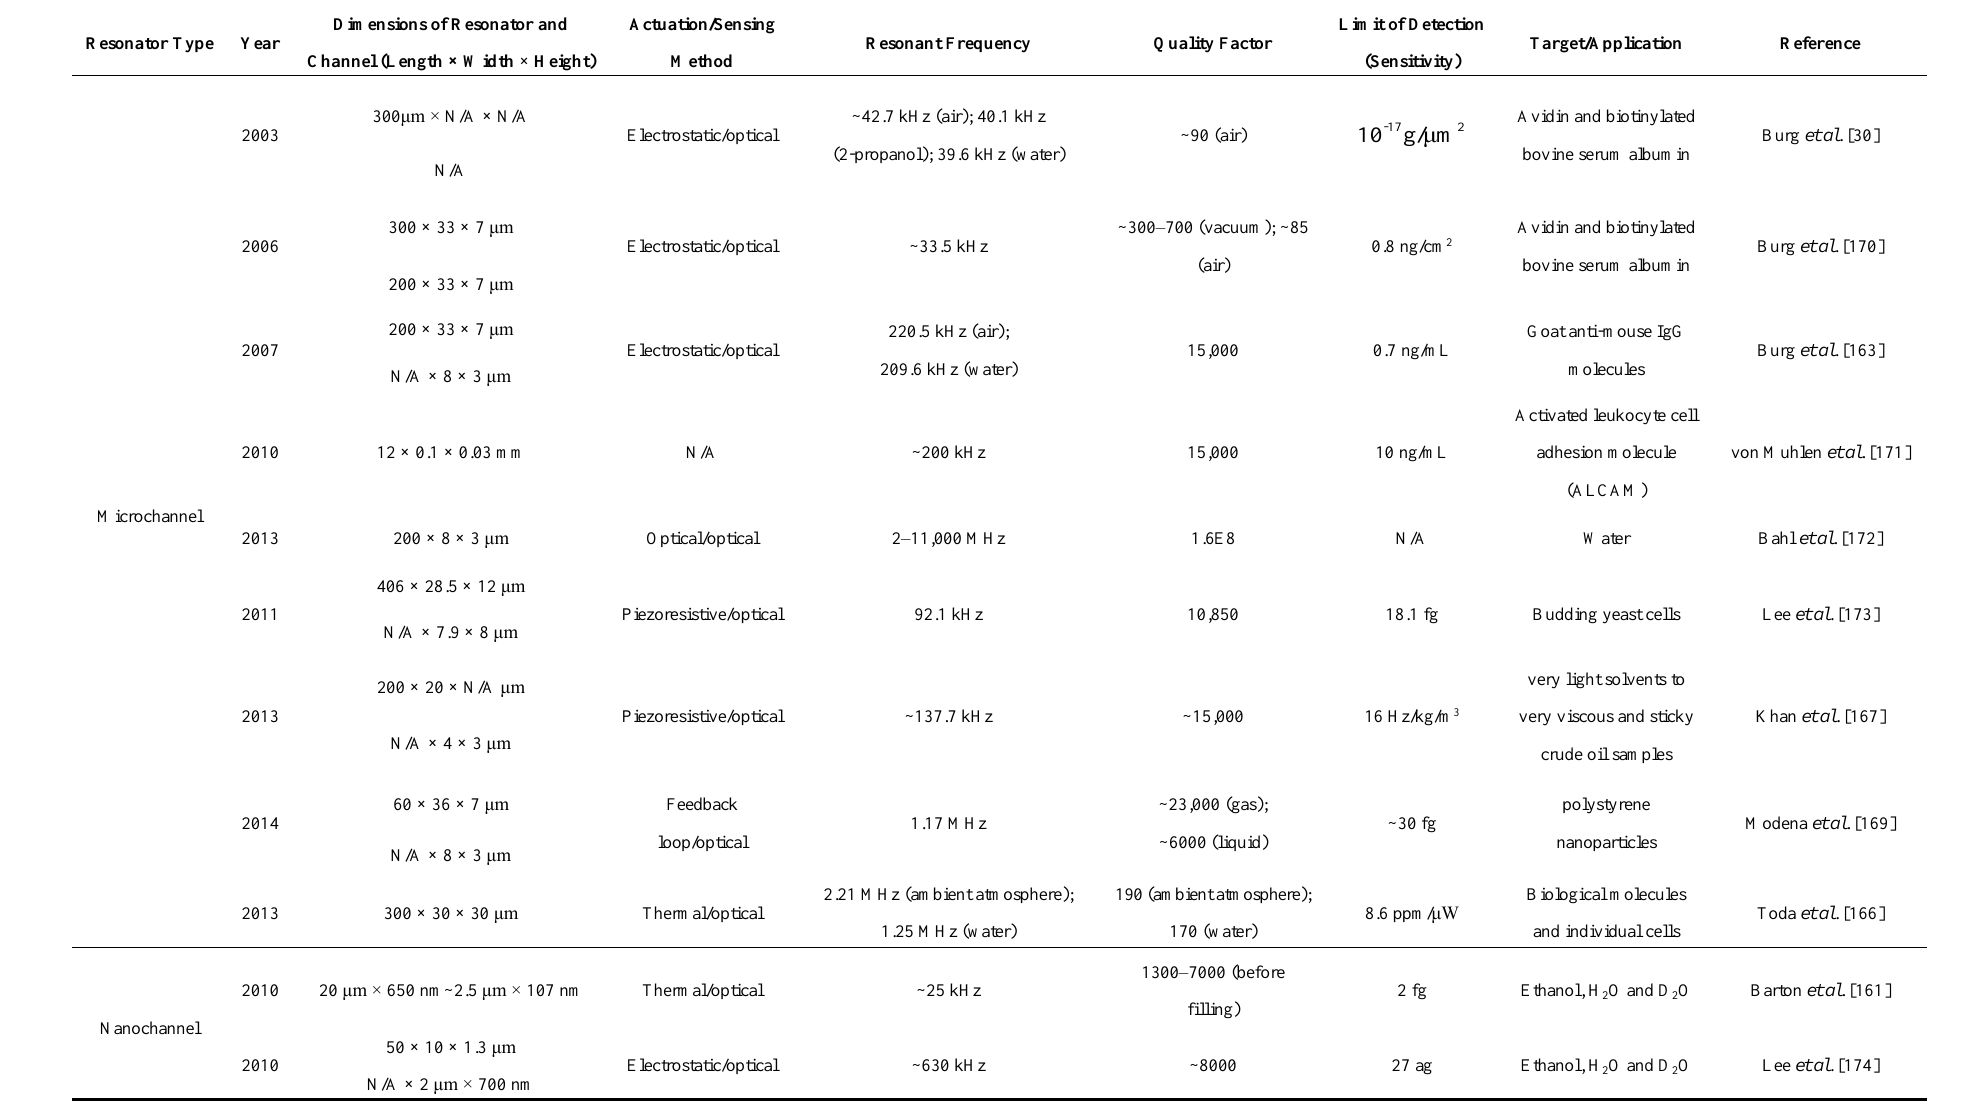
Table 4. Overview of some suspended micro- and nanochannel